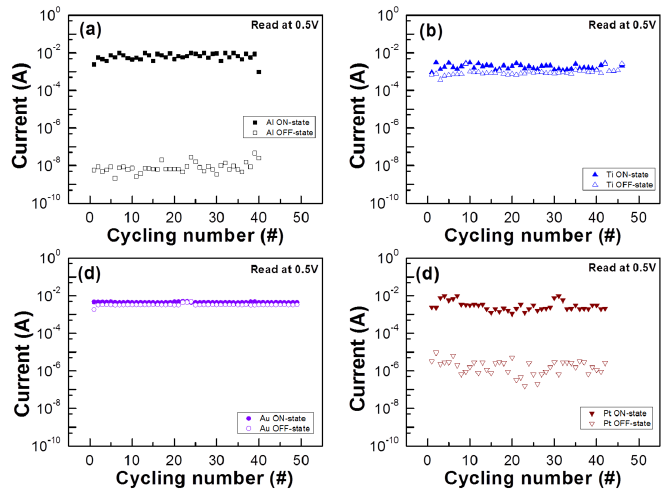
Figure 6. Endurance performance of the top electrode/STN/ITO structure with top electrode material of ( a ) Al; ( b ) Ti; ( c ) Au; and ( d ) Pt RRAM operated at room temperature.